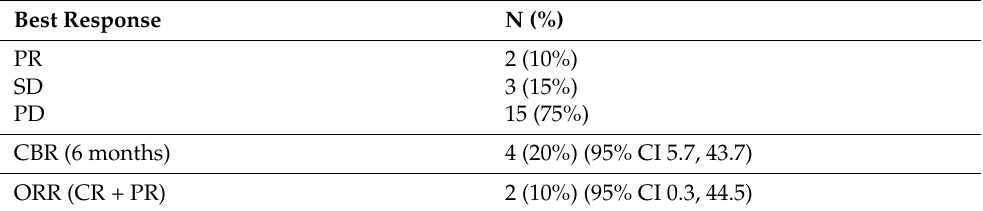
Table 2. Evaluable Response per RECIST 1.1 (N =